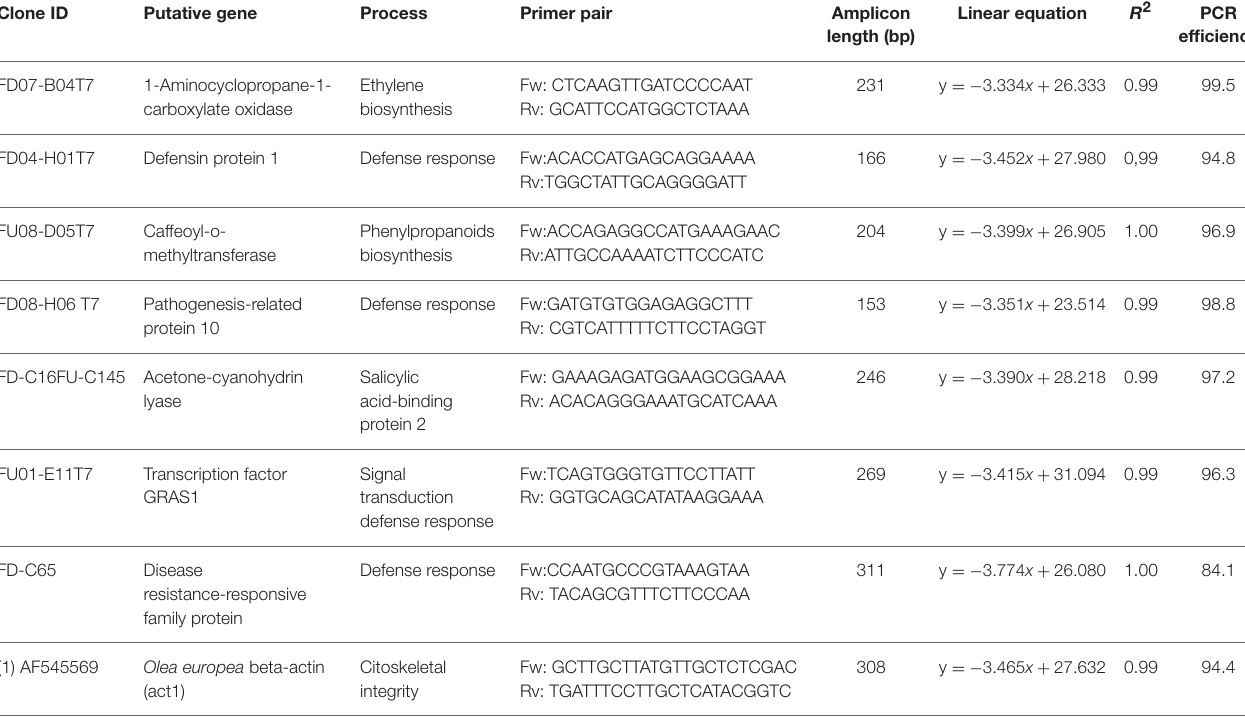
TABLE 1 | List of selected transcripts induced in “Frantoio” aerial tissues upon Verticillium dahliae colonization used in qRT-PCR experiments. Clone